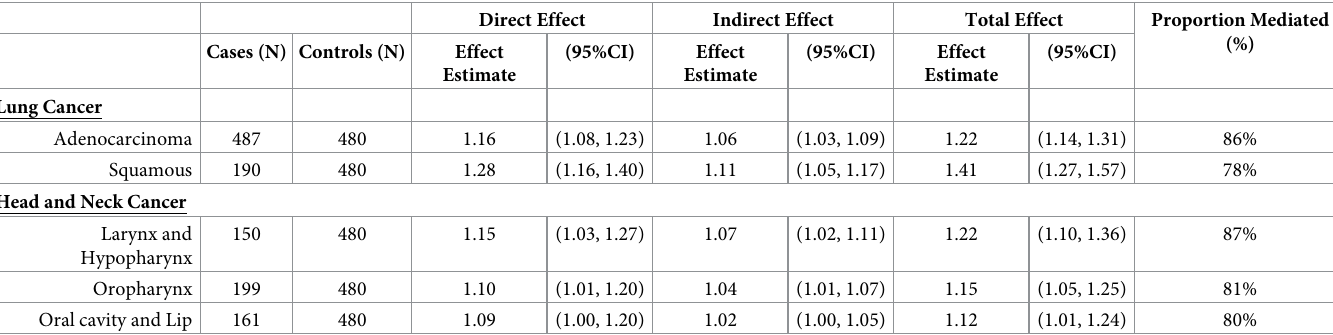
Table 3. The Effect of nicotine dependence by lung cancer histology and head and neck cancer subsite, mediated through duration of